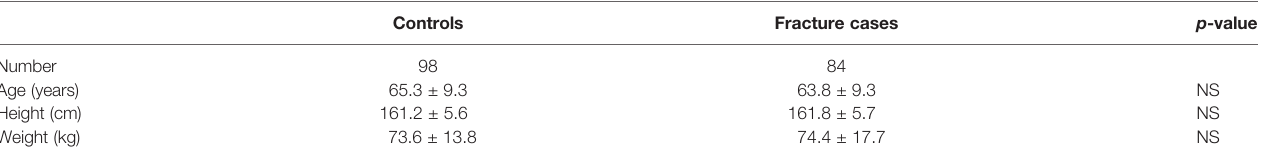
Values are shown as mean ± standard deviation. Two-sample t-test.